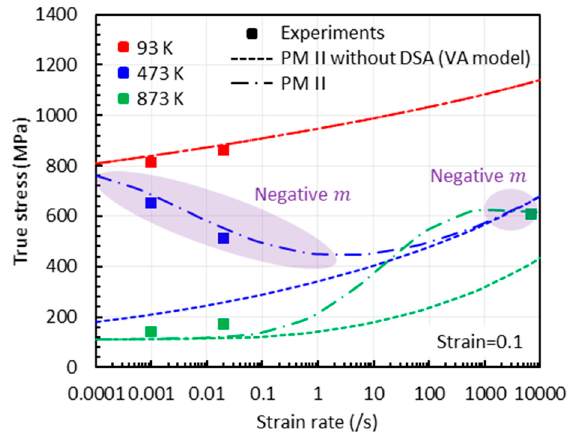
Figure 25. True stress versus strain rate graphs with three temperatures ( 93 (cid:1837) , 473 (cid:1837) , and 873 (cid:1837) ) at ε = 0.1. The experimental data are from [1] .